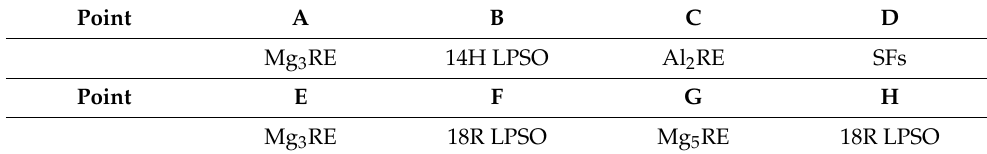
Figure 10. BF-TEM images along with the corresponding SAED patterns of the polygonal phases in as-cast alloy: ( a , b ) 0.5Zn-1.0Al and ( c , d ) 0Zn-1.0Al.